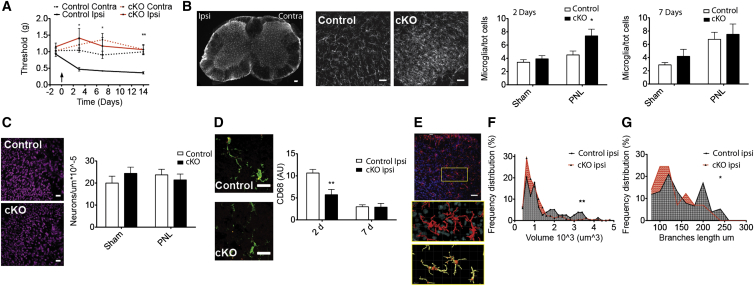
Microglial TMEM16F Is Required for the Development of Mechanical Hypersensitivity in the PNL Neuropathic Pain Model(A) Paw withdrawal thresholds of TMEM16Ffl/fl (control) and LysMcre/TMEM16Ffl/fl(cKO) mice showing ipsilateral (ipsi) and contralateral (contra) paw withdrawals before and after partial nerve ligation (PNL). n = 9; p < 0.05.(B) From left to right: microglial Iba1 immunofluorescence in the lumbar spinal cord after injury (left side), magnified images from control and cKO tissues 2 days after PNL. Bar graphs show microglial densities in injured (PNL) and non-injured (sham) tissue 2 (left) and 7 (right) days after injury. n = 8/9; p < 0.05.(C) Neuronal marker NeuN immunofluorescence in the ipsilateral dorsal horn from control (top) and cKO (bottom) mice; bar graph showing neuronal density in the imaged volume. n = 10/7; p < 0.05.(D) CD68 (red) and Iba1 (green) immunofluorescence in the ipsilateral dorsal horn from control and cKO mice. CD68 immunoreactivity in Iba1 positive cells at 2 and 7 days after injury. n = 6; p < 0.01.(E) Top: Iba1 (red) and DAPI (blue) immunolabeling in the ipsilateral dorsal horn; 3D image segmentation using IMARIS Bitplane surface (middle) and filament (bottom) algorithms.(F) Frequency distribution of microglial volume in the ipsilateral dorsal horn from control and cKO mice, n = 79/277 cells; p = 0.005.(G) Frequency distribution of microglial total branch length in the ipsilateral dorsal horn from control and cKO mice; p = 0.0293.Values are mean ± SEM. Scale bars represent 100 μm (B), 30 μm (C), 20 μm (D), 40 μm, and 7 μm (E). See also Figures S2 and S3.